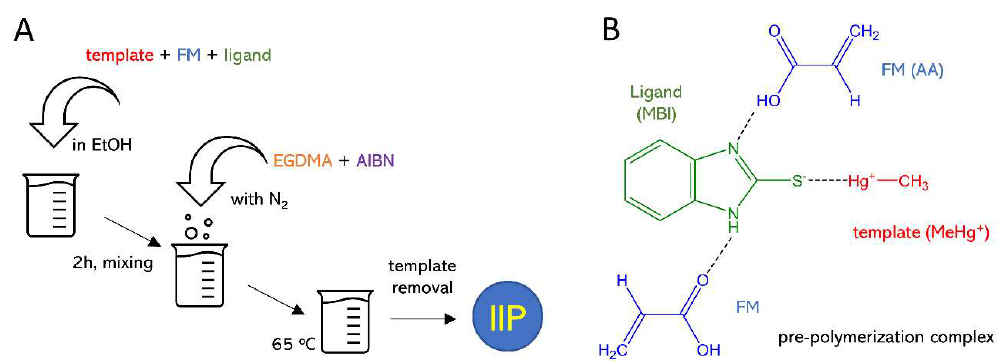
Figure1. Schematicillustrationofthesynthesisofion-imprintedpolymers(IIPs)( A );pre-polymerization Figure 1. Schematic illustration of the synthesis of ion-imprinted polymers (IIPs) ( A ); pre- complex with the 2-mercaptobenzimidazole (MBI) ligand ( B polymerization complex with the 2-mercaptobenzimidazole (MBI) ligand ( B ).